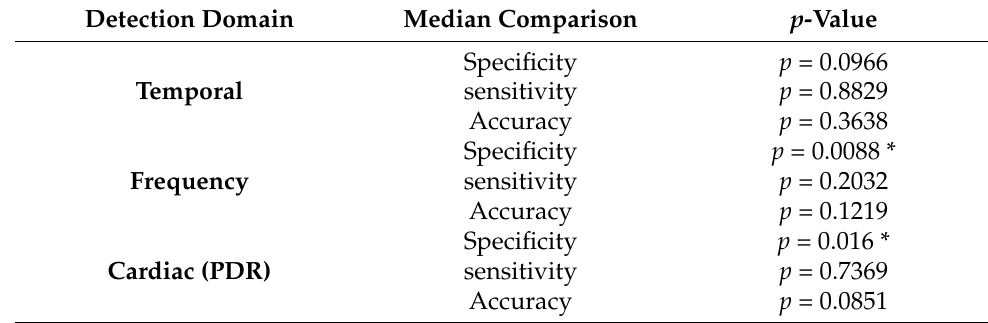
Table 4. Median values comparing for specificity, sensitivity and accuracy of each detection domain— NR + AP vs. RS + RN. * p -value < 0.05, difference between the two paired samples was significantly different.